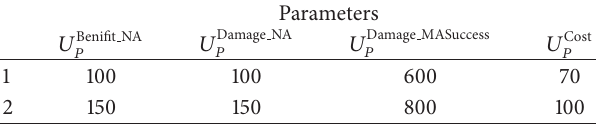
Table 1: Parameters settings of the example on Scene